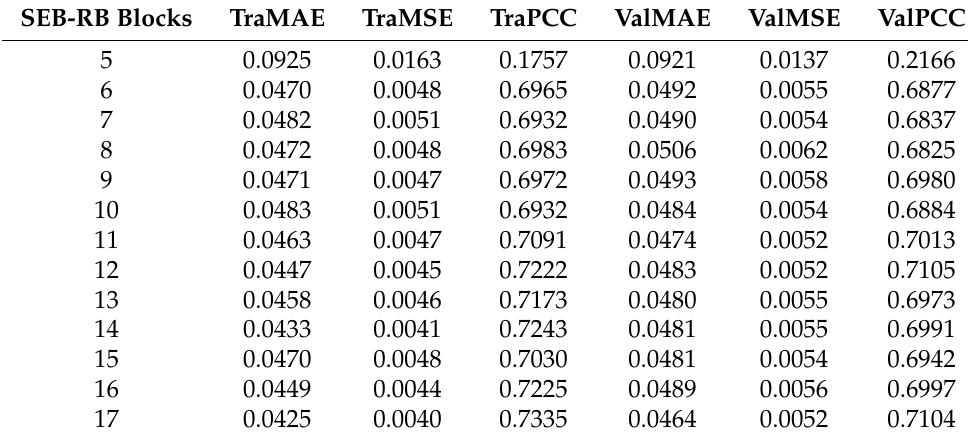
Table 2. Effect of the number of SEB-RB blocks 1